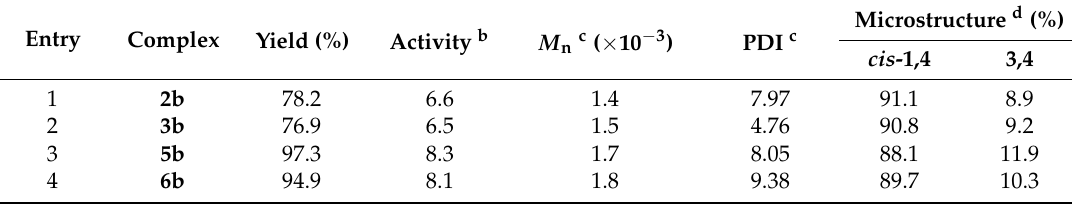
Table 2. Isoprene polymerization results with Co(II) catalyst a .